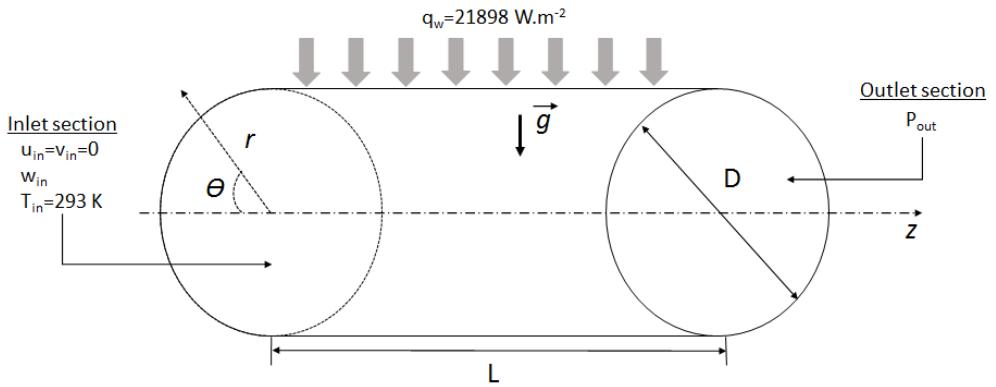
Figure 1. Schematic view of the computational domain with the boundary